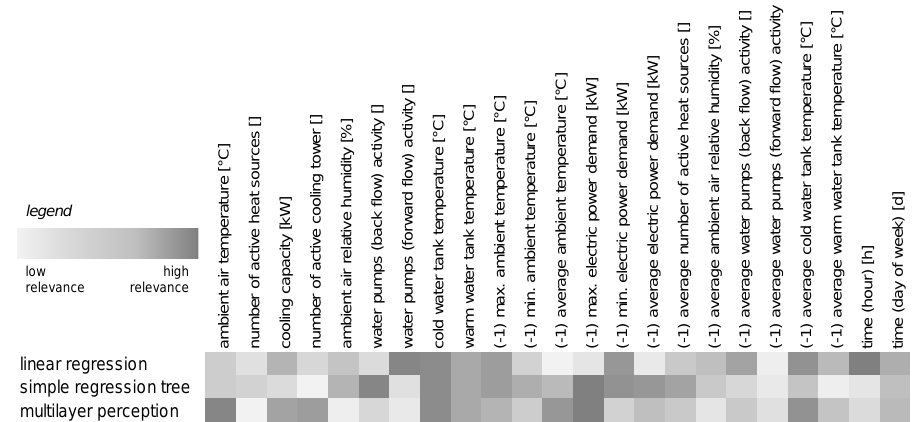
Figure 13. Heatmap from feature selection indicating relevance of variables for selected algorithms assessed for electric power demand (dark grey color indicates high relevance).